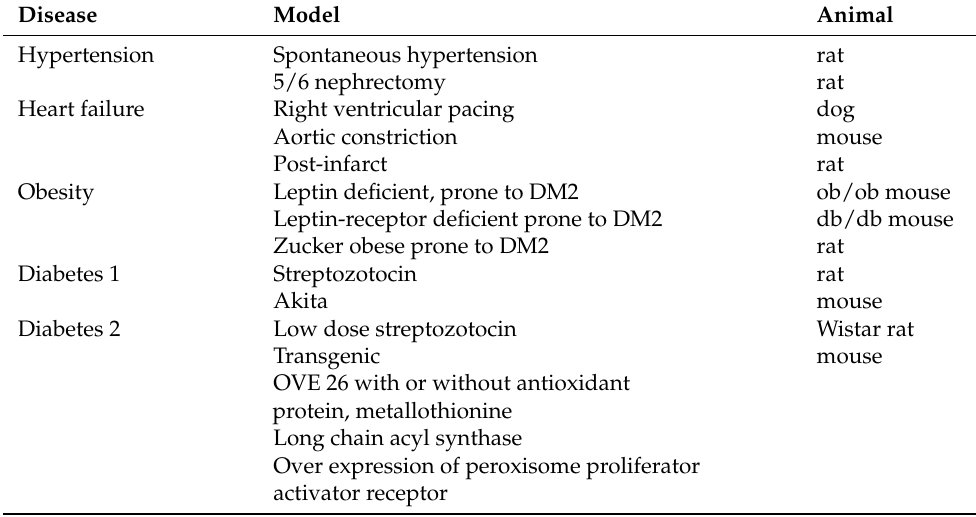
Table 2. Animal Models for